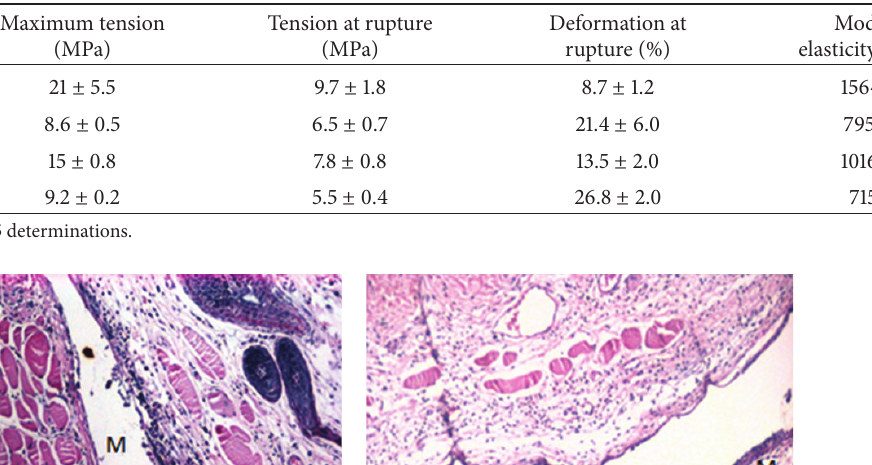
Table 5: Maximum tension, tension at rupture, deformation at rupture, and modulus of elasticity ( 𝐸 ) obtained in the tensile strength tests of PLDLA/PCL-T membranes.